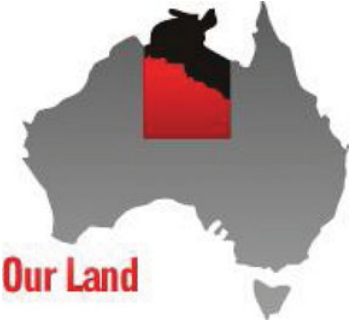
(Colour online) Geographical region of the Central Land Council (shown in red) within the Northern